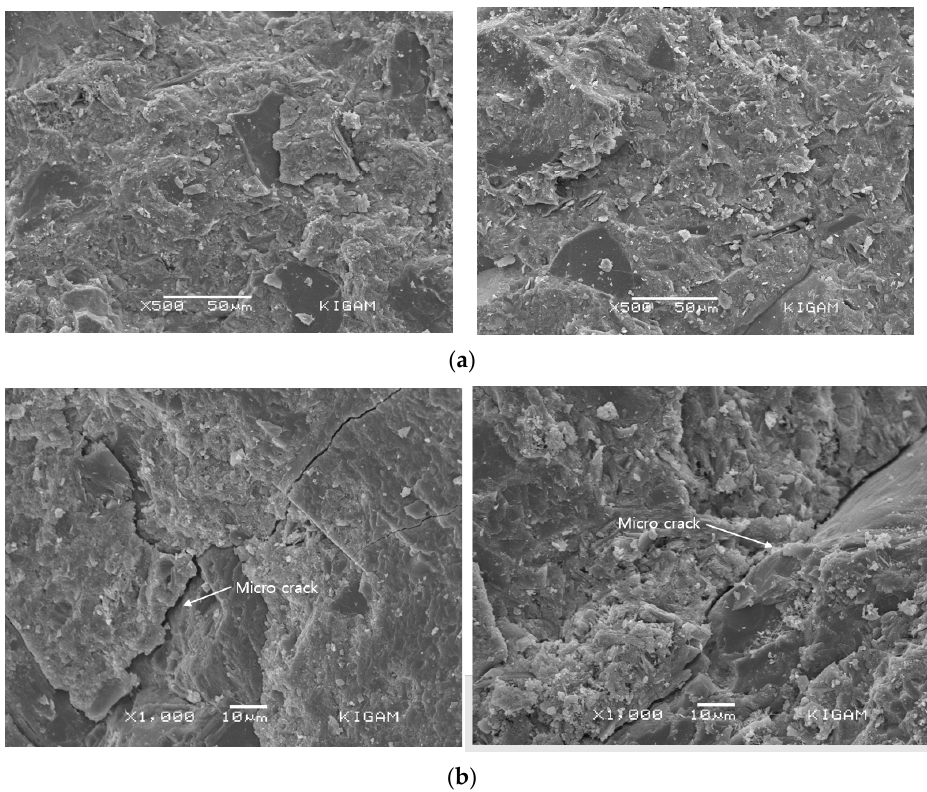
Figure 13. Scanning electron microscopy observation result (by location of exposure): ( a ) atmospheric pressure exposure test specimen (onshore control room); ( b ) air pressure exposure test specimen (bypass room).